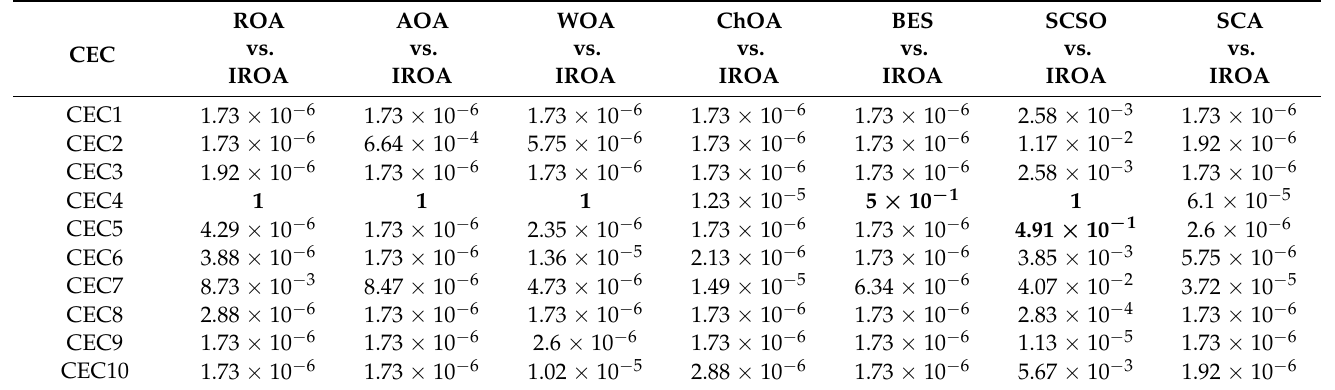
Table 7. Wilcoxon rank sum test results of each algorithm in CEC2020 benchmark function.